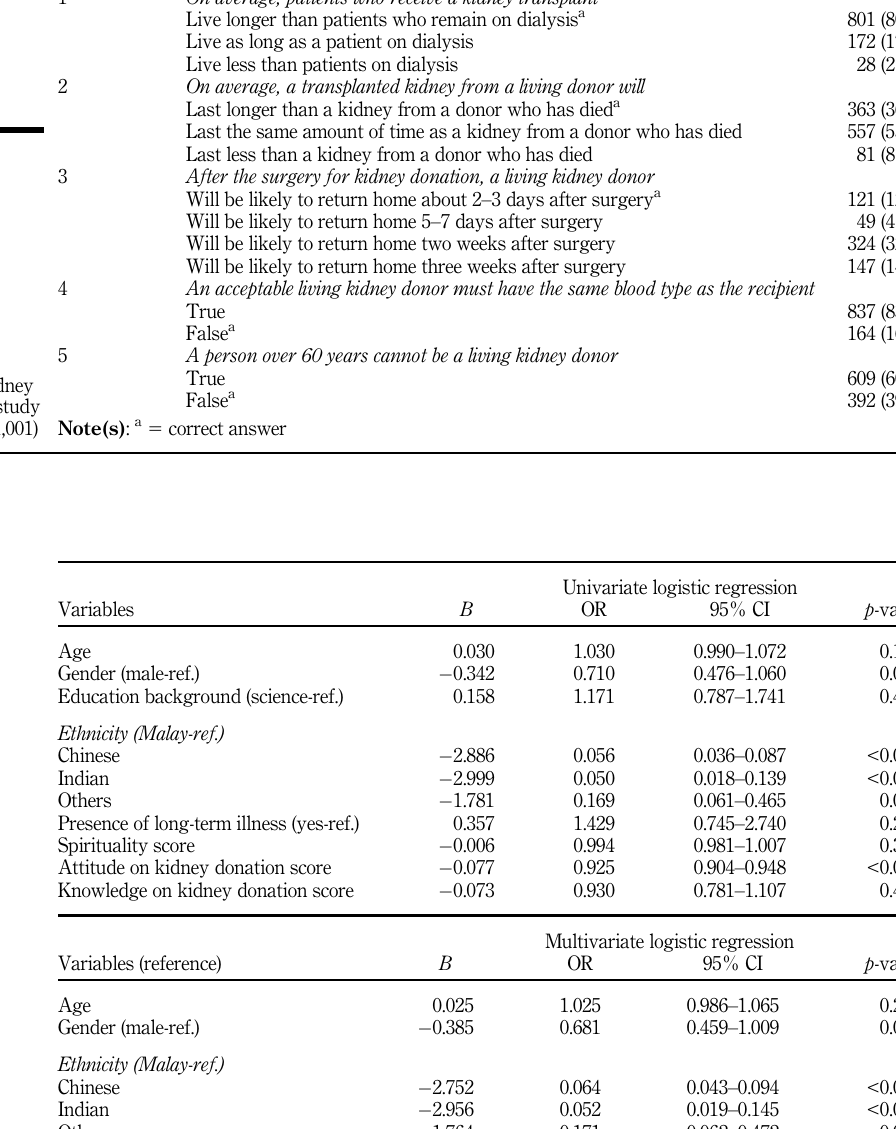
Table 5. Univariate and multivariate logistic regression on willingness to donate a